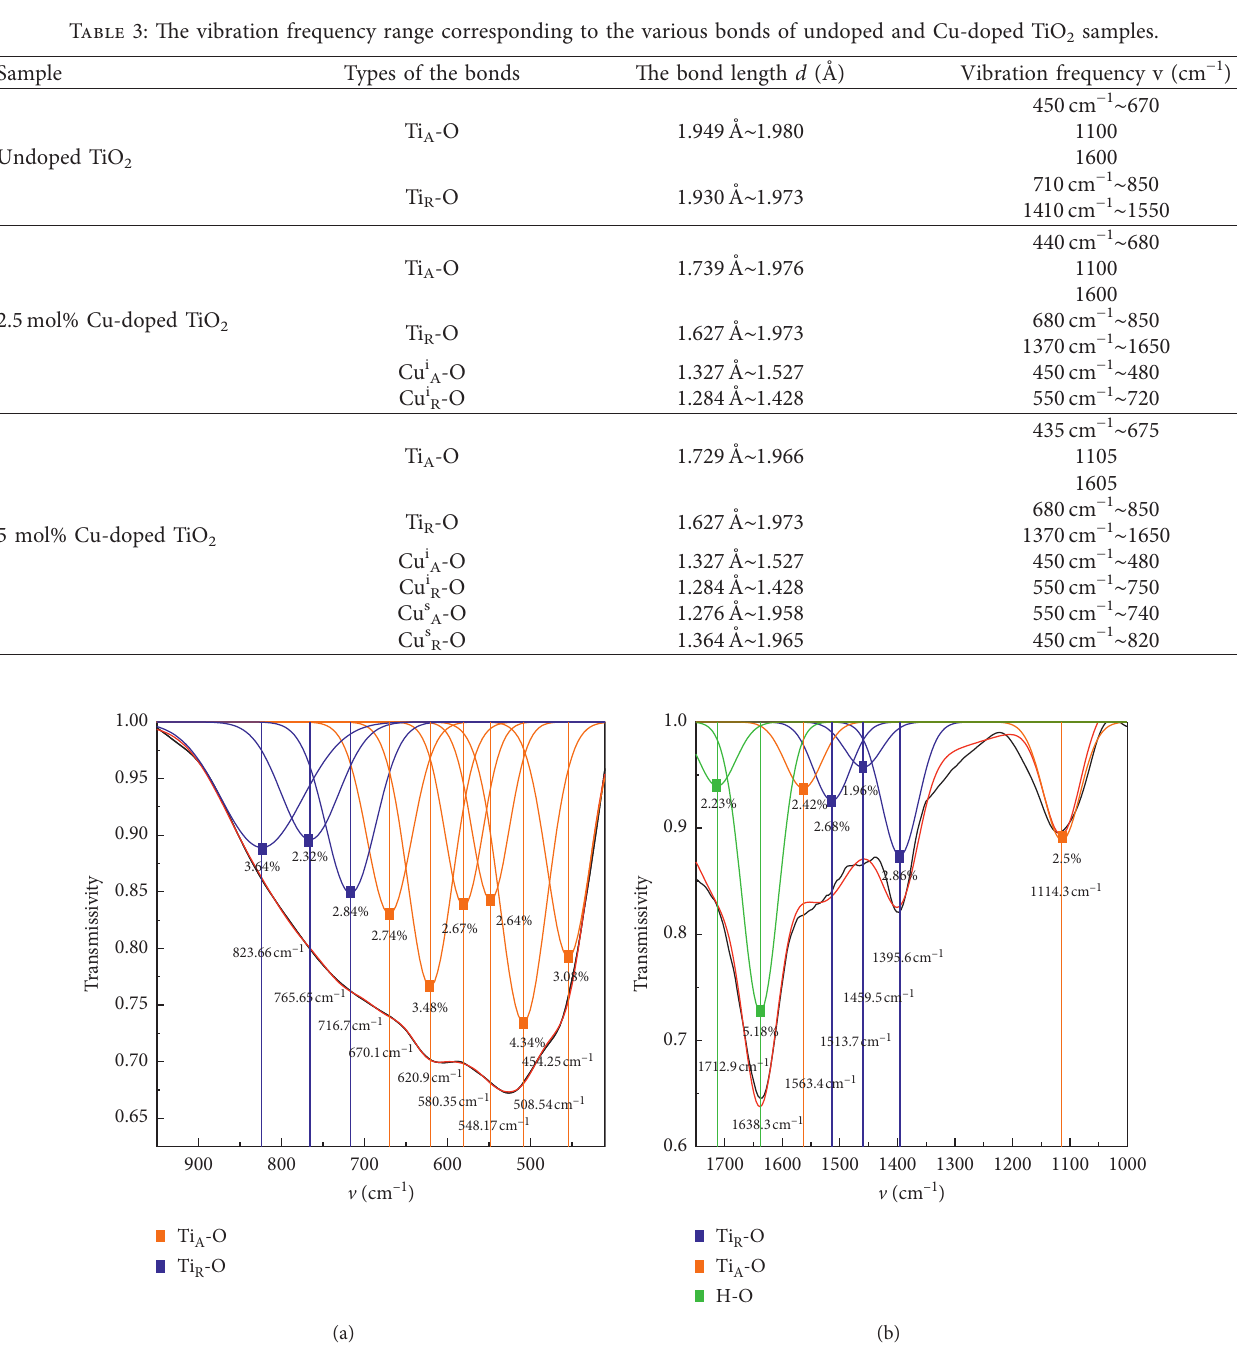
Figure 5: Infrared spectra of the undoped TiO 1000cm − 1 ∼ 1800cm − 1 . Table 4: Infrared spectra of the undoped TiO The type of